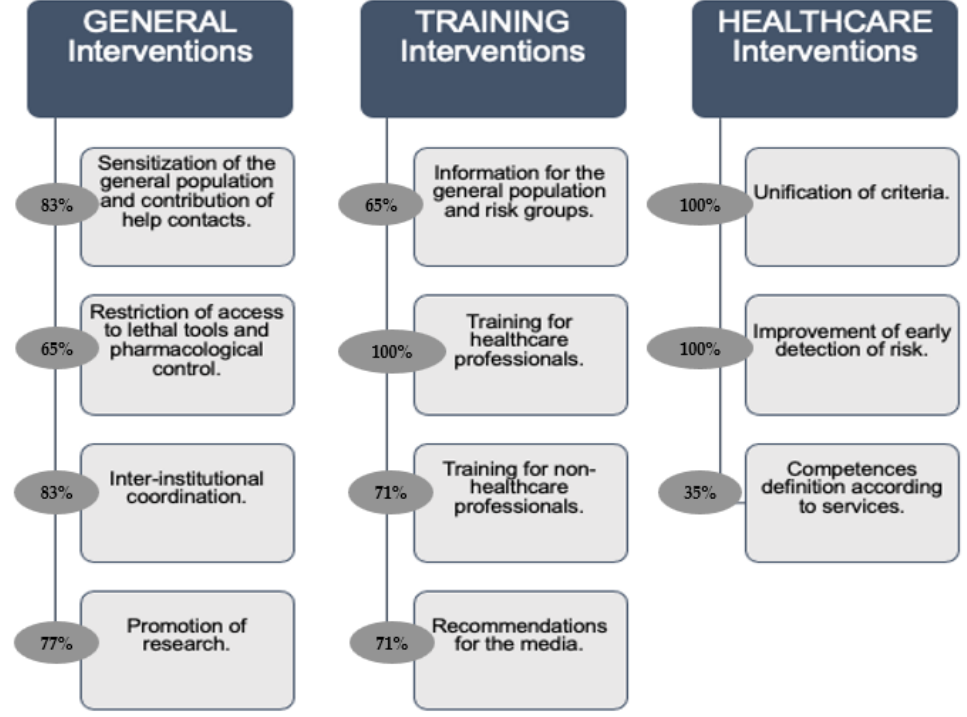
Figure 2. Categorisation of suicide prevention interventions and percentage of provinces that carry them out.